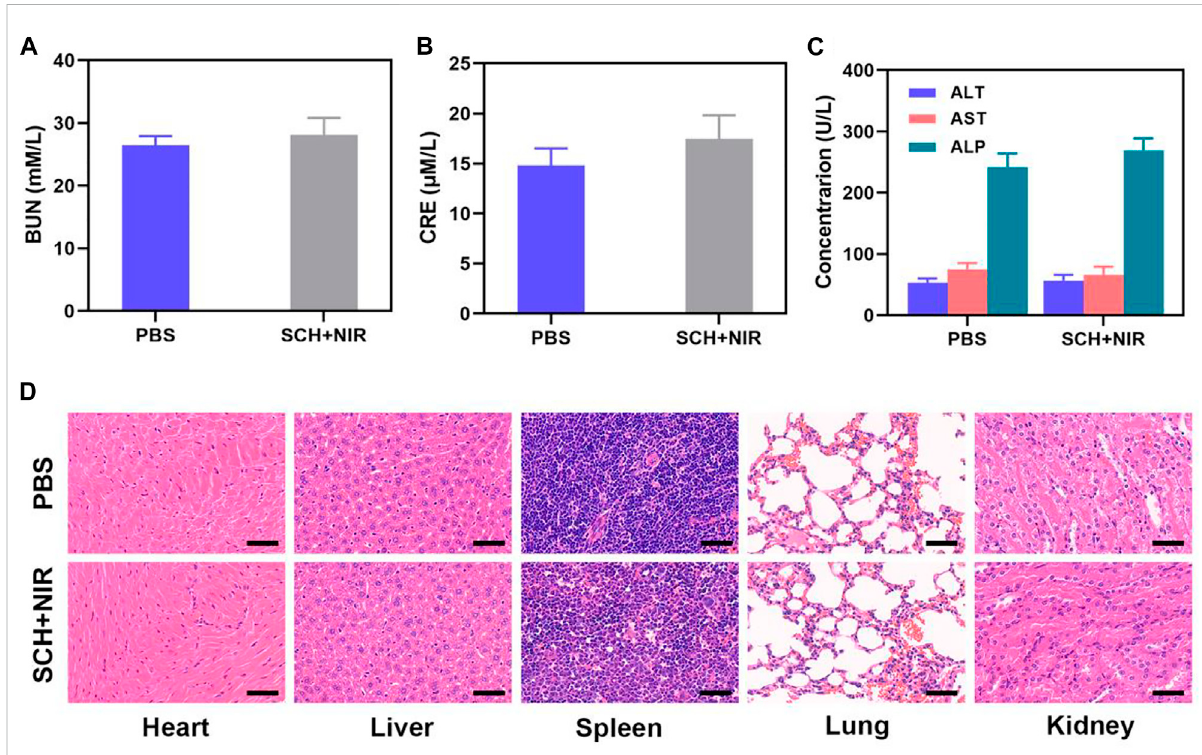
FIGURE 4 (A) Kidneyfunctionmarkers:BUN, (B) CRE,and (C) Liverfunctionindicators:ALT,AST,andALPfollowingdifferenttreatments.(n=3). (D) Results of histopathological examination (H&E-stained images) of the mice ’ s major organs, including the heart, lung, liver, kidneys, and spleen, after exposure to various therapies 14 days after the injection. (n = 3). Scale bars: 50